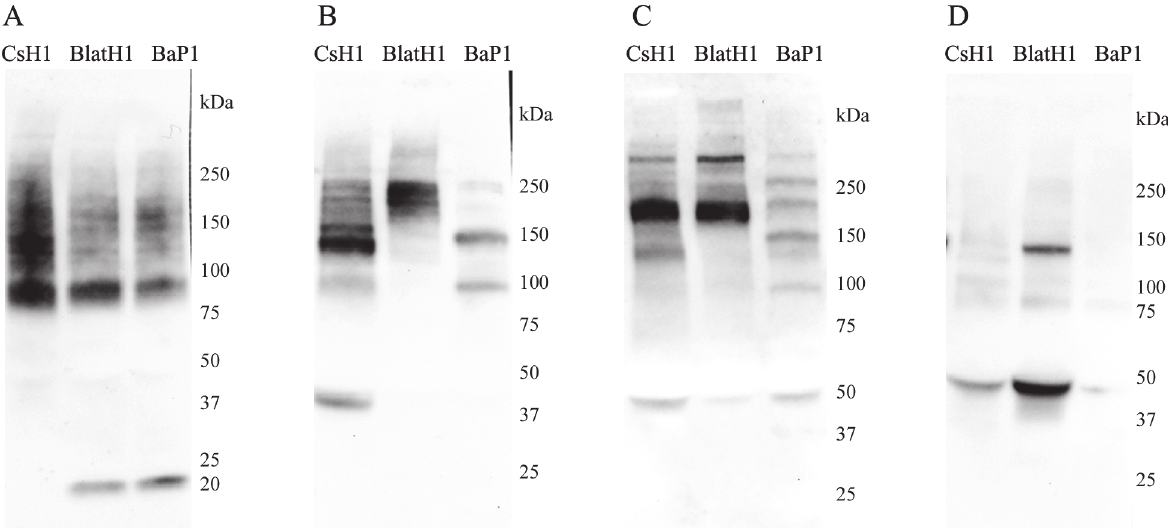
Fig 4. Western blot analysis of basement membrane components in exudates collected from the gastrocnemius. Groups of five mice were injected in the right gastrocnemius with either BaP1 (PI, 75 μ g), BlatH1 (PII, 3 μ g), or CsH1 (PIII, 50 μ g) SVMPs. After 15 min, mice were sacrificed, a 5 mm incision was made in the skin overlying the injected muscle, and a heparinized capillary tube was introduced under the skin to collect the wound exudate fluid; exudate samples from a single treatment were then pooled. Afterwards, 100 μ g of protein of each sample was separated under reducing conditions on 4 – 15% Tris – HCl SDS-PAGE, and transferred to nitrocellulose membranes. Immunodetection was performed with (A) anti-collagen type IV, (B) anti-collagen type VI, (C) anti-laminin, and (D) anti-nidogen 1. The reaction was detected using an anti-rabbit peroxidase antibody and a chemiluminescent substrate. Images were obtained with the ChemiDoc XRS+ System